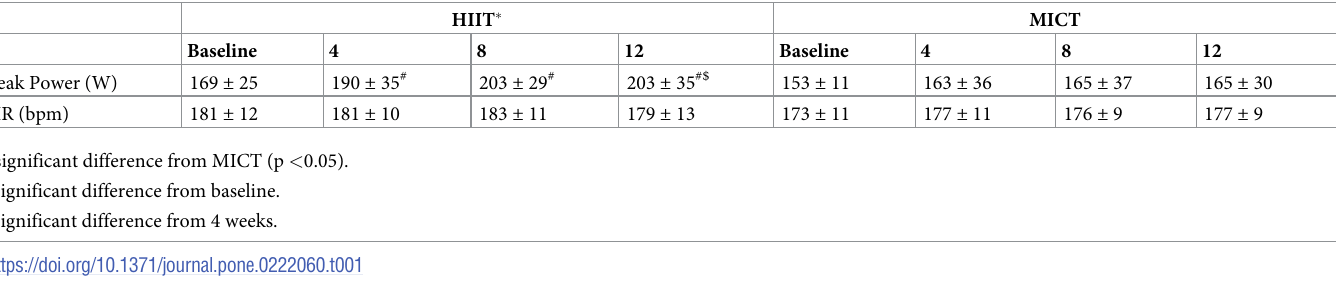
Table 1. Mean ± SD peak power and HR during the exercise tests at baseline and weeks 4, 8 and 12 for HIIT and